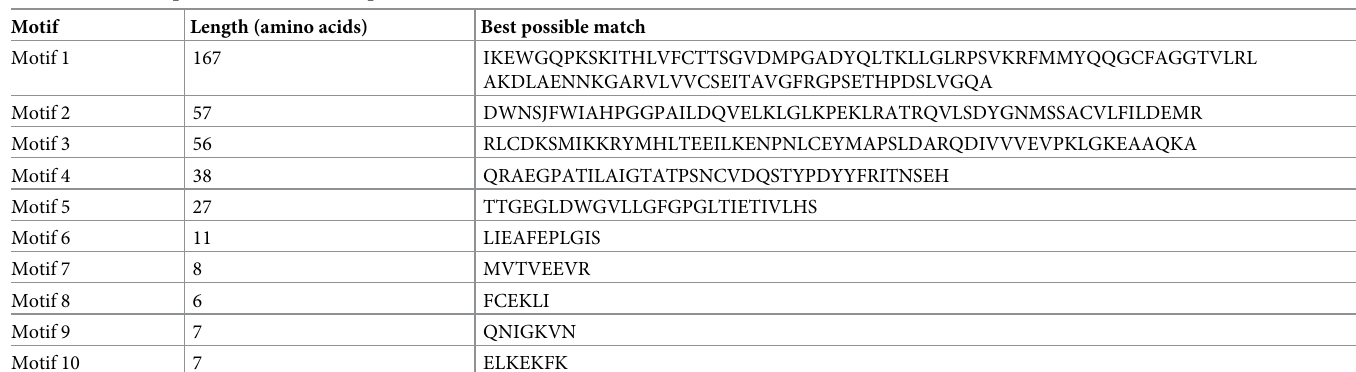
Table 2. List of the putative motifs of CHS